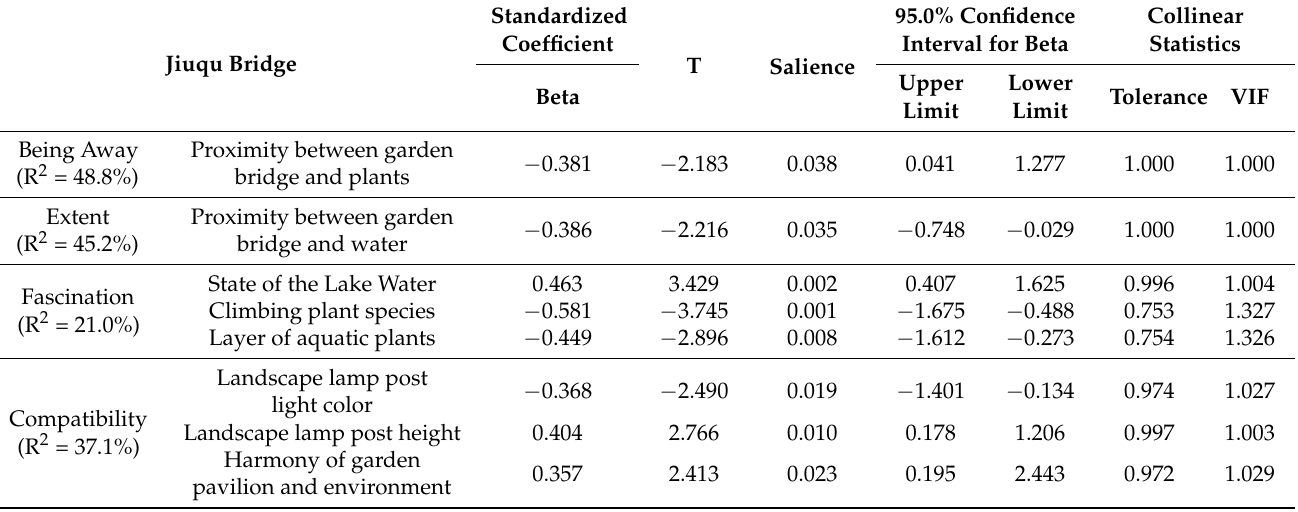
Table 3. Correlation between Spatial Landscape Element Characteristics and Restorative Perception in Jiuqu